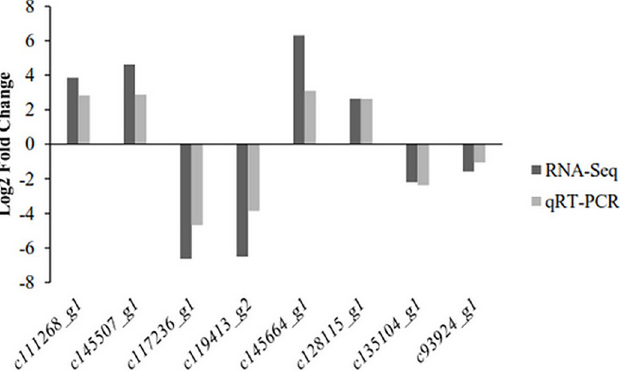
Fig 8. Validation of DEGs data by qRT-PCR. ‘CK’ means well-watered control plants without ethephon pre- treatment. ‘Drought’ means drought-stressed plants without ethephon application. ‘ETH_D’ means drought-stressed plants with ethephon